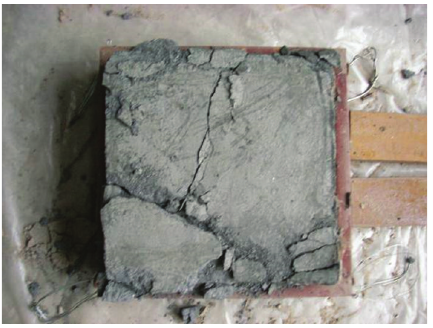
Figure 22: Coal burst figure.